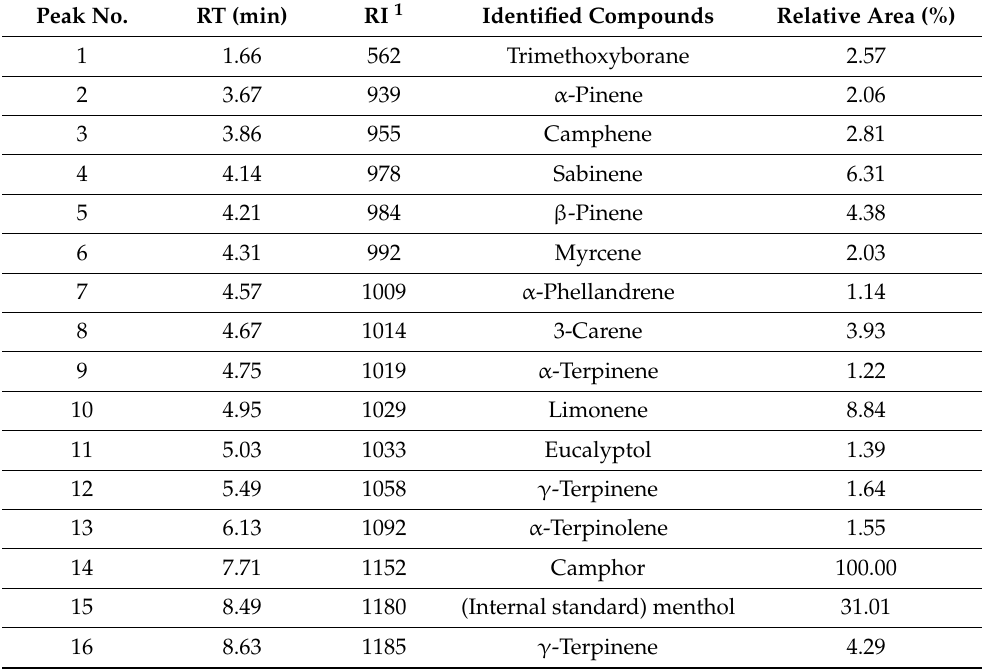
Table 2. The volatile composition of the anti-cellulite emgel analyzed by using HS-GCMS. Peak